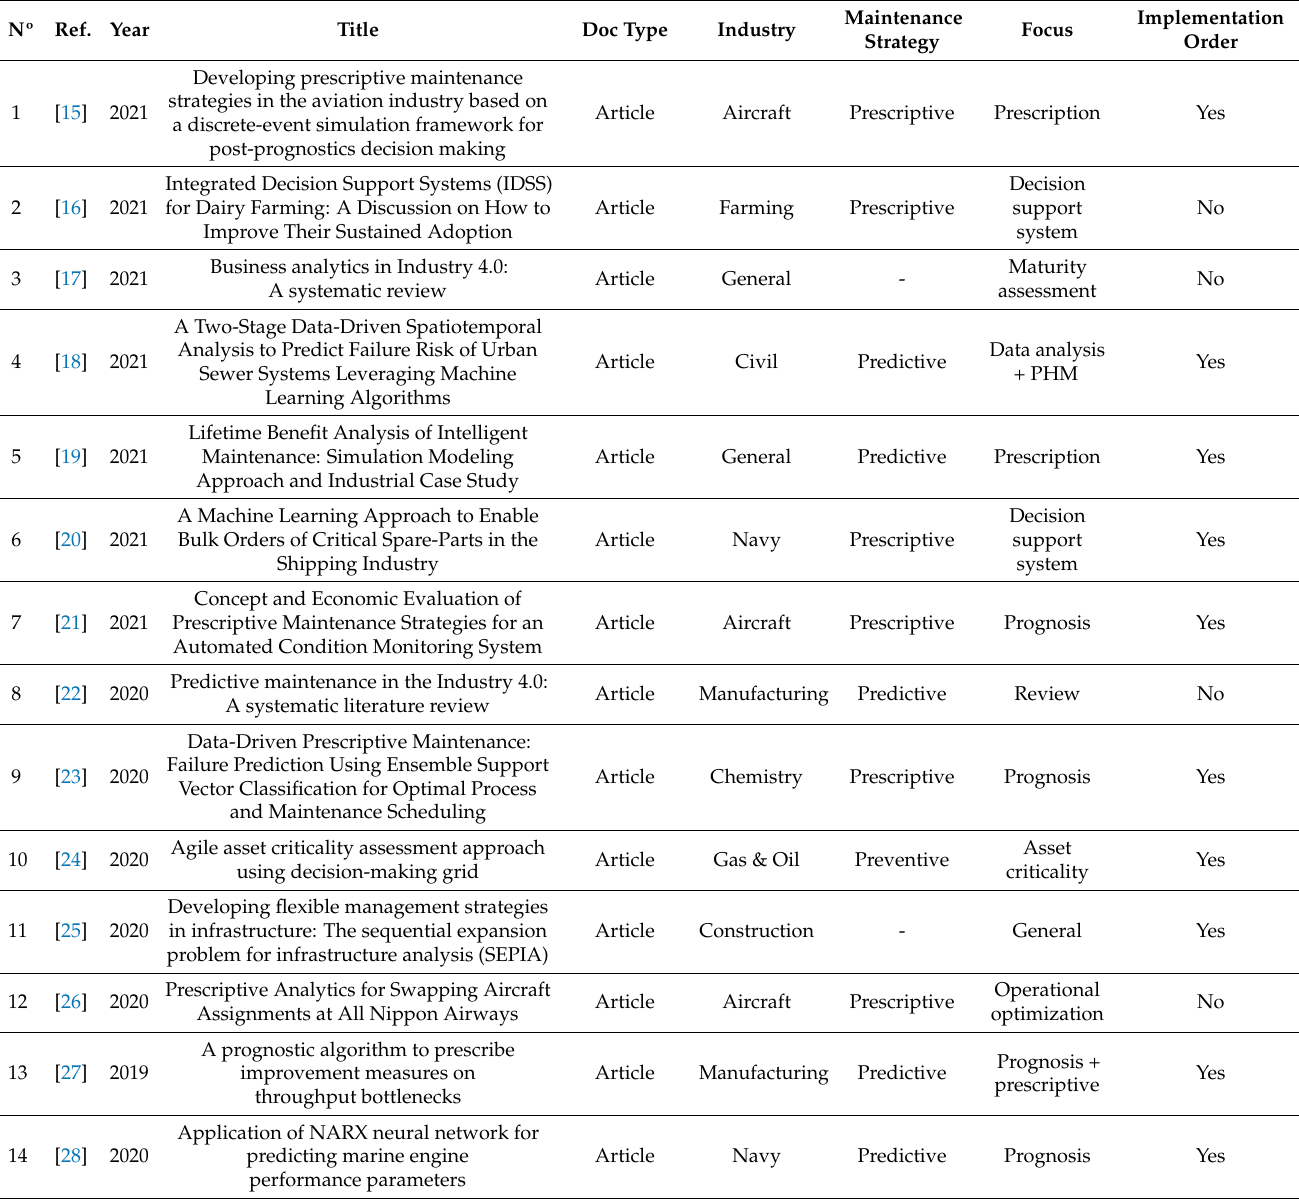
Table 1. List of the analyzed